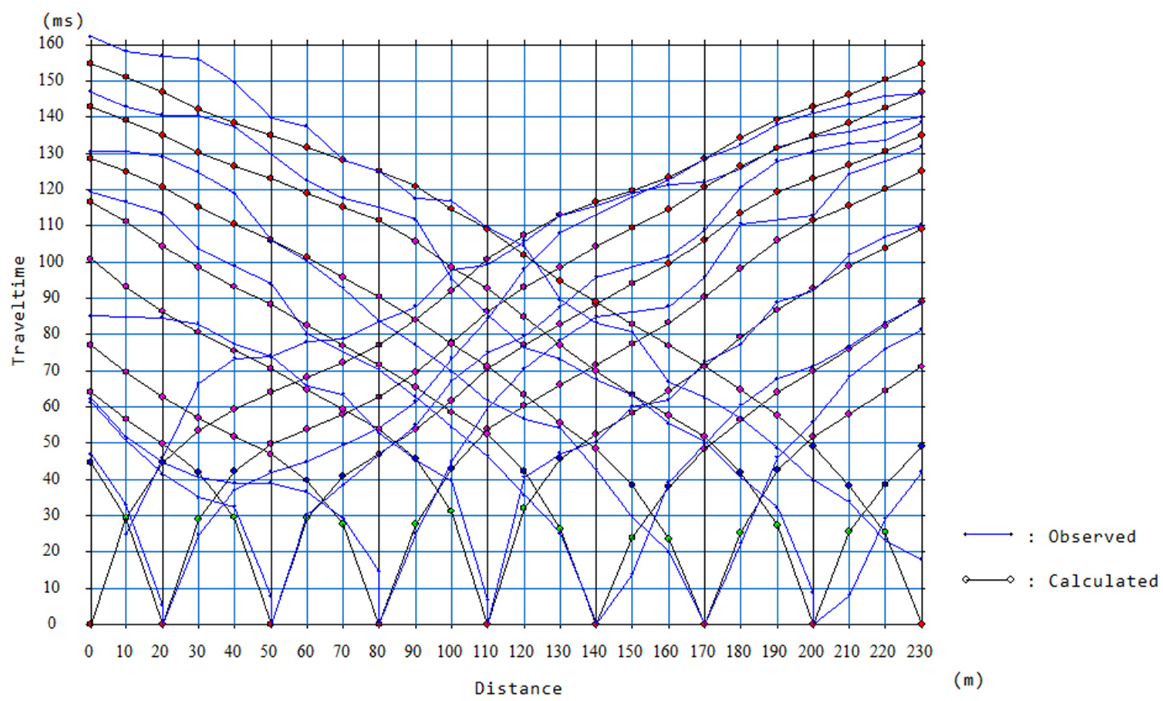
Figure 5. Time-distance plot of profile Seis_1. The presence of velocity lateral variations is clear between 70 and 80 m distance and around at 145–150 m distance.